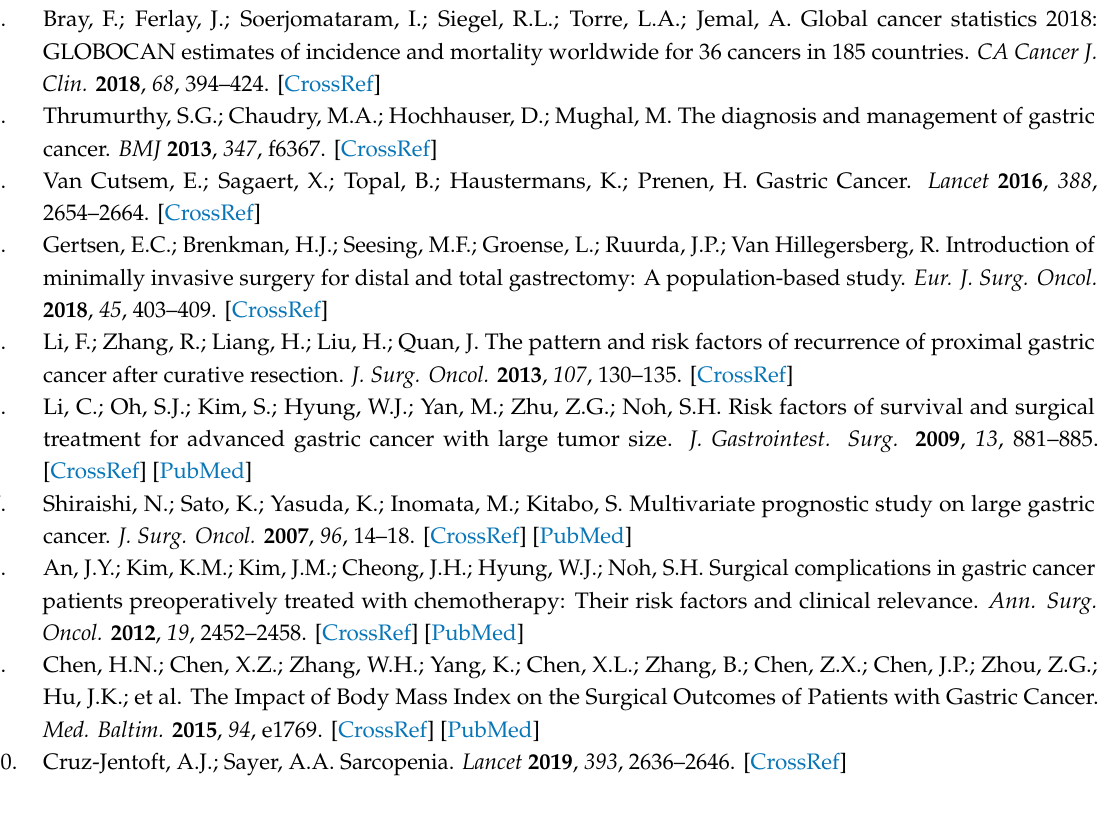
Table S1: Overview of search strategy, Table S2: Applied definitions of the 3-point scale per domain of QUIPS, Figure S1: Overview of the risk of bias score of the included studies following QUIPS, Figure S2: Funnel plot of included studies reporting on postoperative complications, Figure S3: Funnel plot of included studies reporting on severe postoperative complications, Figure S4: Funnel plot of included studies reporting on overall mortality, Figure S5: Funnel plot of included studies reporting on disease-specific